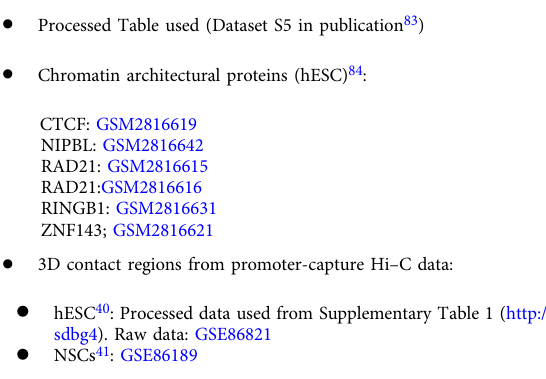
● Processed Table used (Dataset S5 in publication 83 ) ● Chromatin architectural proteins (hESC) 84